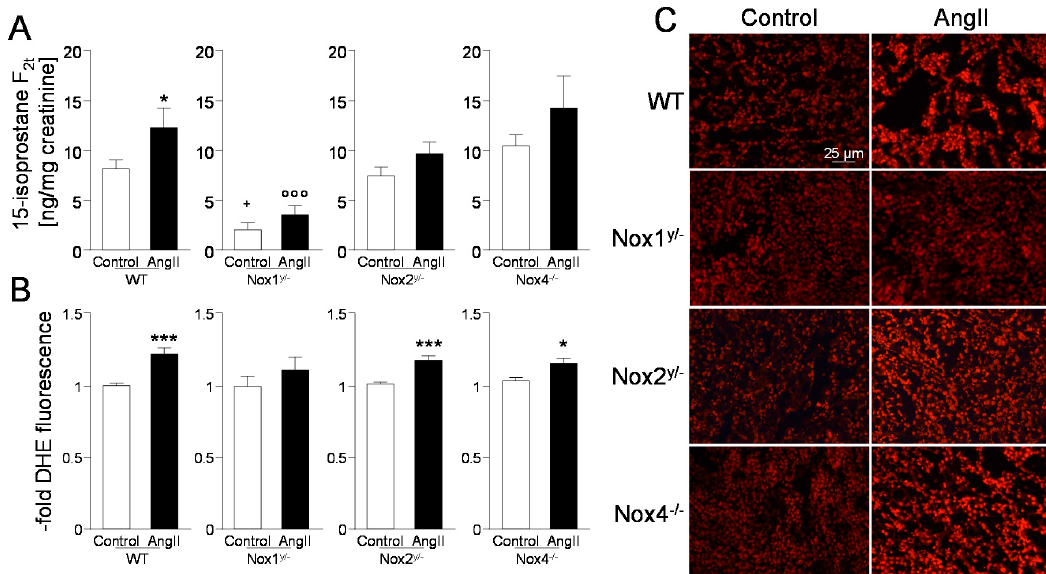
Figure 4. Angiotensin II led to systemic oxidative stress only in wildtype mice, but also to local oxidative stress in Nox2 and Nox4 knockout mice. ( A ) Systemic oxidative stress measured as excretion of 15-isoprostane F 2t in urine; ( B ) Local oxidative stress in the kidney measured with the help of the redox sensitive dye dihydroethidium and quantified with the cell image analysis softwares, CellProfiler [20] or ImageJ; ( C ) Representative pictures of DHE stained kidney tissue of all groups (100-fold magnification). Data are shown as mean + SEM. * p ≤ 0.05, *** p < 0.001, vs. the respective control animals analyzed by the Student’s t -test; + p ≤ 0.05 (F(1.39) = 3.97) vs. control WT animals; ◦◦◦ p < 0.001 (F(1.39) = 27.00) vs. angiotensin II-treated WT animals, analyzed by two-way